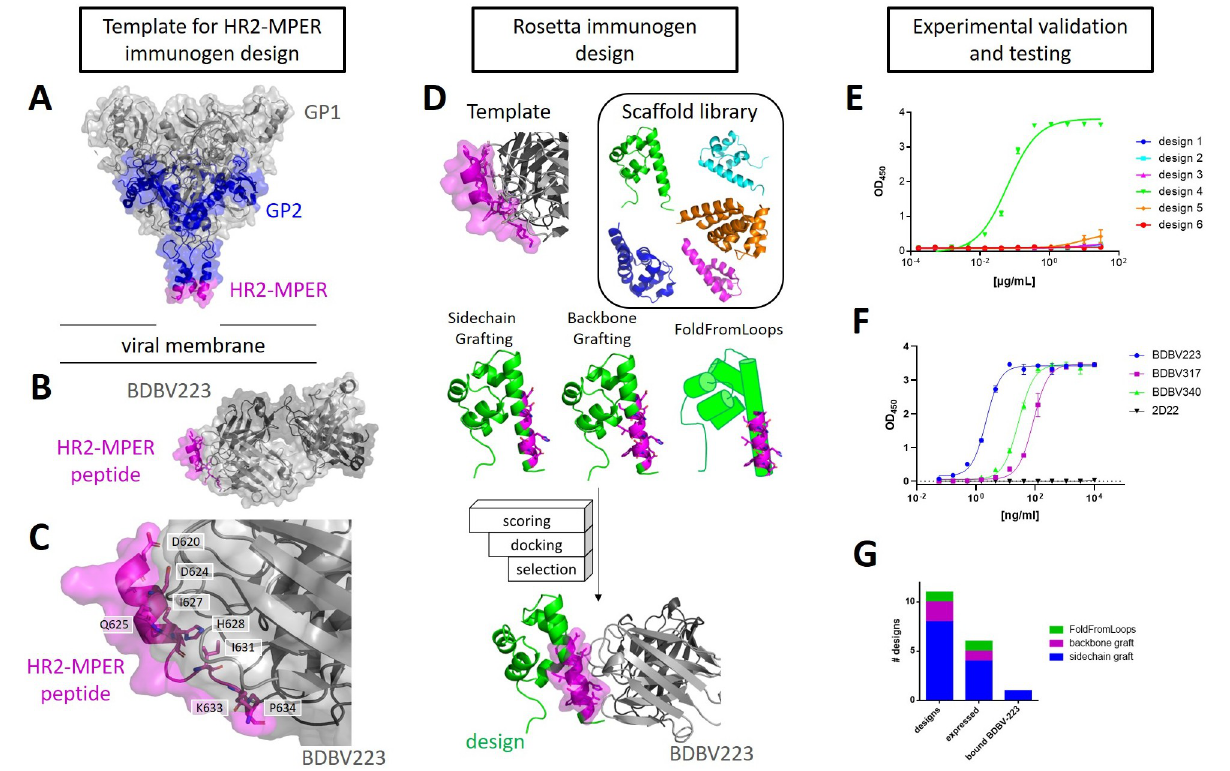
Fig 1. Computational design and initial experimental validation of the BDBV-MPER based immunogens. (A) BDBV GP, as observed in PDB: 6DZM [32], contains the soluble parts of GP1 and GP2, but not the HR2-MPER region. (B) Monoclonal antibody BDBV223 bound to the BDBV-MPER peptide (PDB: 6N7J) [21]. (C) A close-up view of the interactions of BDBV-GP with the BDBV-MPER peptide via critical interaction residues. (D) Rosetta grafting protocols are employed over a scaffold library containing small, highly resolved proteins, to transfer the epitope through Rosetta’s grafting protocols sidechain and backbone grafting, and FoldFromLoops [16, 18, 33]. (E) Out of eleven selected designs, six designs expressed from E . coli were tested for binding to BDBV223. Design 4, a sidechain graft of the epitope residues on the crystal structure PDB 1B0X, strongly bound to BDBV223 in ELISA (n = 2, duplicates, exemplary experiment plotted with standard deviation (SD); reference EC 50 value for BDBV223 binding to the BDBV-MPER peptide has been reported as 85 ng/ml [14]; for further reference curves compare S1 Fig). (F) Binding of all three known BDBV-MPER targeting antibodies BDBV223, BDBV317 and BDBV340, to the BDBV-MPER carrying immunogen, while the control antibody, 2D22, a dengue E protein targeting antibody [34], does not bind to the immunogen (n = 2, duplicates, exemplary experiment plotted with SD). (G) Designs from sidechain grafting were the most prominent selected group tested. The selected design based on FoldFromLoops and one of the selected designs from backbone grafting were expressed but did not bind. The binding immunogen was one out of eleven